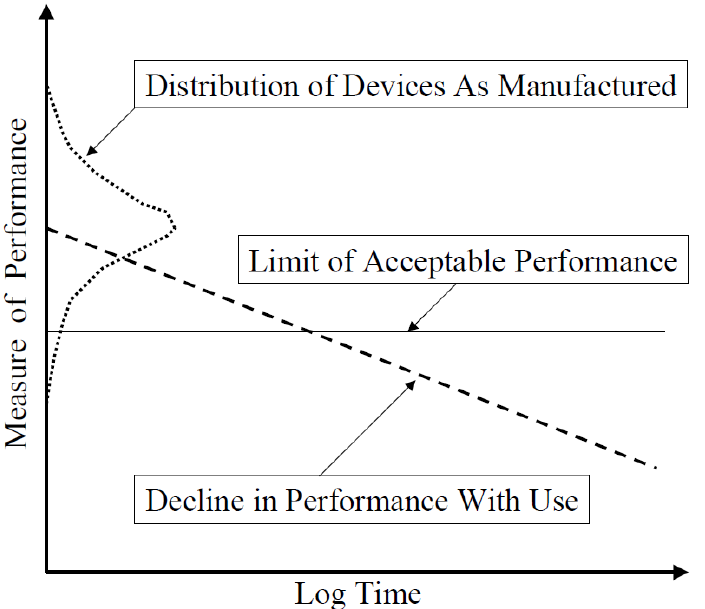
Figure 1. Schematic of the relationship between quality and reliability. The vertical axis represents some key performance parameters, such as the accuracy of a MEMS device. There is a distribution in such a parameter in the devices as they are manufactured and before their use (dotted line). Some devices have unsatisfactory performance; that is, they fall below the limit of acceptable performance (solid line), and therefore must be rejected. Devices above limit contributions to the yield of the manufacturing process. The dashed line shows a hypothetical linear decline in performance with time. Its intersection with the solid line gives the time at which a device in use no longer performs adequately.